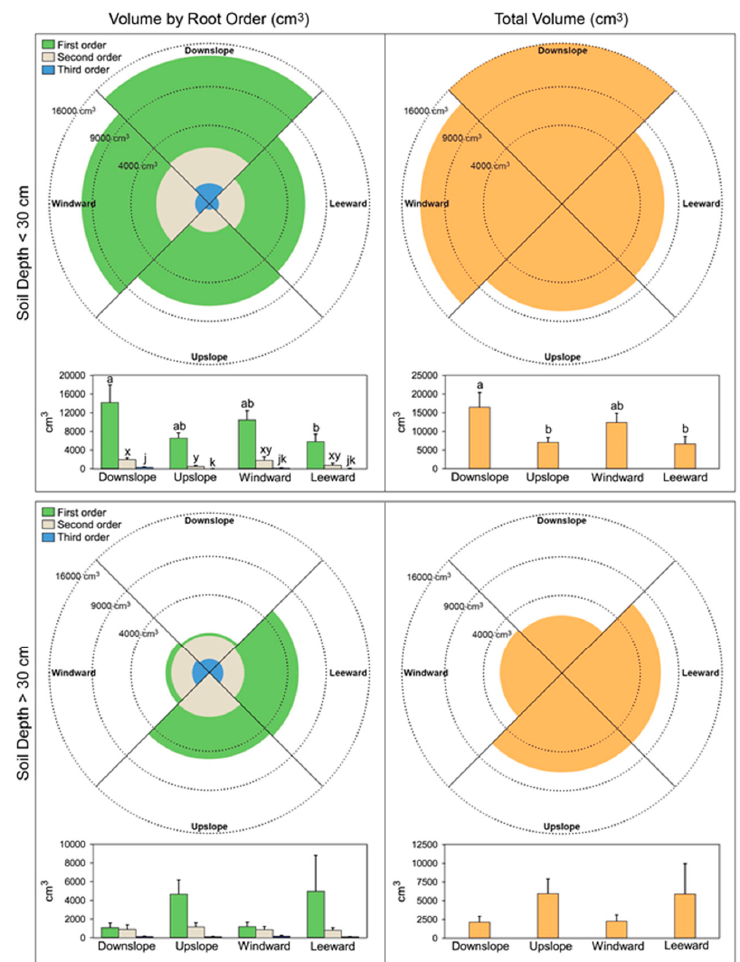
Figure 5. Volume of lateral roots present in the cage according to branching order (left column), pulled together (right column), and at different depths (< 30 cm upper panels, > 30 cm lower panels) in each quadrant. Letters within each order, quadrant, and soil depth combination indicate significant differences ( p < 0.05); absence of letters reflects that no significant difference was detected. Vertical boxes represent approximately 50% of the observations and lines extending from each box are the upper and lower 25% of the distribution. Within each box, the solid horizontal line is the median value and the dotted line is the mean.